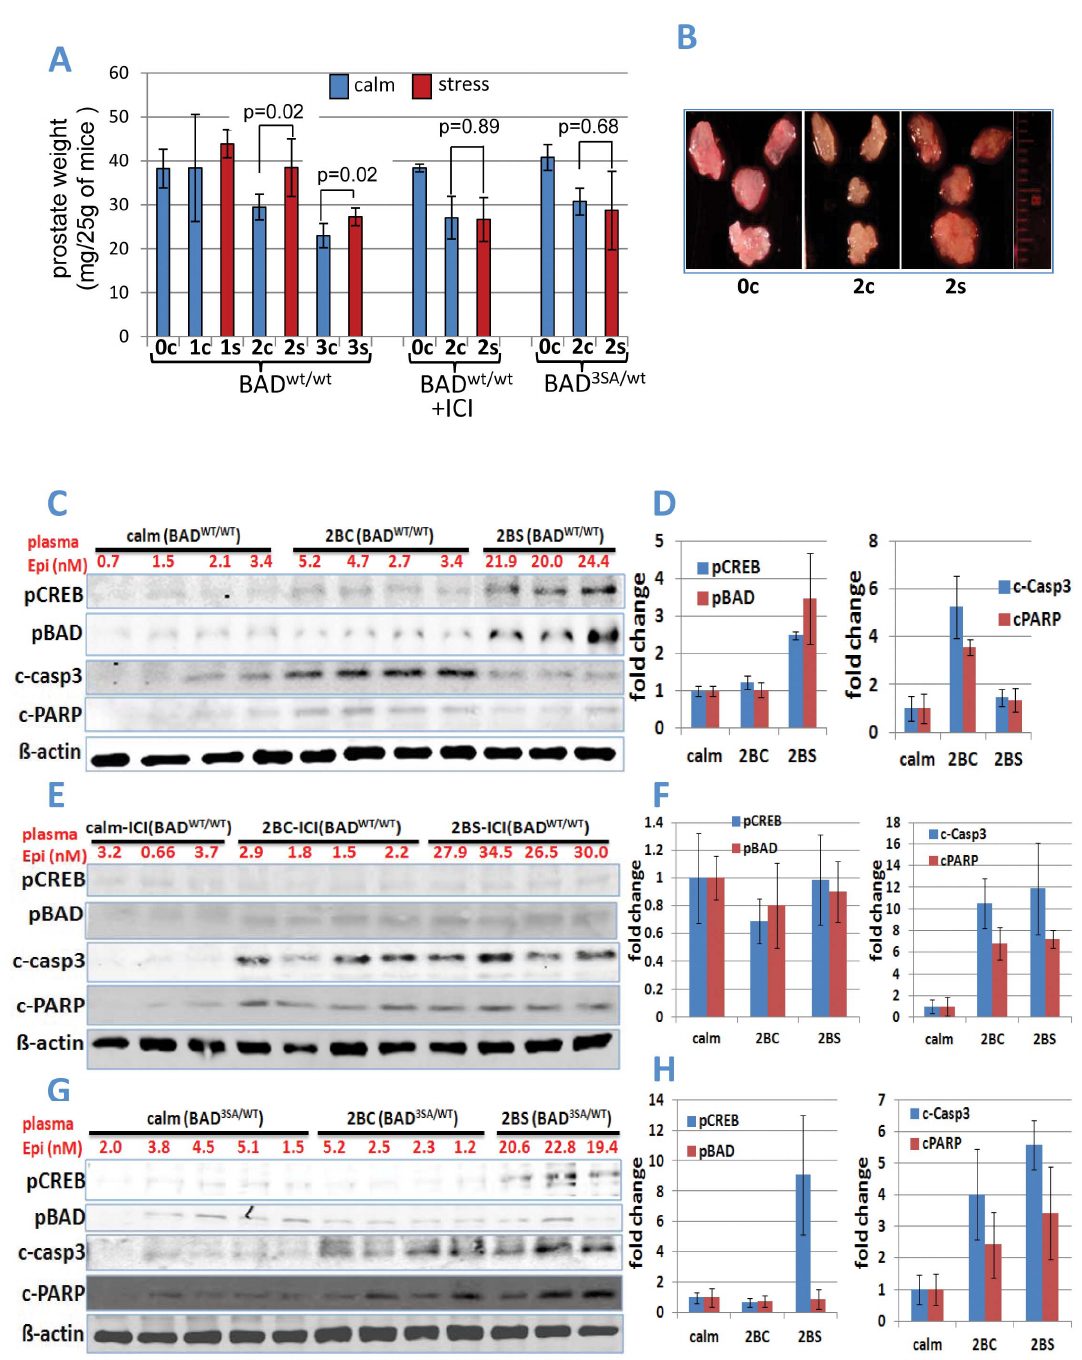
Figure 2. Behavioral stress delays androgen ablation-induced prostate involution and apoptosis via b 2-AR and BAD phosphorylation. A) Stress attenuates bicalutamide-induced decrease in prostate weight of mice via ADRB2/BAD signaling. S=stressed; C=calm. Intact calm mice (0c), numbers under the columns indicate days of bicalutamide treatment; BAD wt/wt mice with wild type BAD; BAD wt/wt + ICI, mice treated with ICI118,551; BAD 3SA/WT , mice with knockin on phosphorylation-deficient BAD3SA mutant (n=3 to 5 in each group). B) Microphotographs of dissected prostate glands from intact wild-type ( 0c ), calm mice after 2 injections of bicalutamide ( 2c ), and stressed mice after 2 injections of bicalutamide ( 2s ). ( C–H ) Western blot and densitometric analysis of Western blots of proteins extracted from of anterior prostate glands of wild-type mice (BAD WT/WT ) (C, D); wild-type mice treated with ICI118,551 (ICI, BAD WT/WT ) (E, F); and transgenic mice that express phosphorylation-deficient mutant BAD (BAD 3SA/WT ) (G, H). ( C, E, G ) Western blots conducted with antibodies to pSer133CREB (pCREB), pSer112BAD (pBAD), cleaved caspase 3 (c-casp3), cleaved PARP (cPARP) and b -actin. 3–4 representative samples for each treatment group are shown. Numbers over the Western blots show plasma epinephrine levels. Calm(BAD WT/WT ), mice with wild type BAD that were not stressed; 2BC(BAD WT/WT ), mice with wild type BAD that were given bicalutamide for 2 days and not stressed; 2BS(BAD WT/WT ), mice with wild type BAD that were given bicalutamide for 2 days and stressed; calm- ICI(BAD WT/WT ), mice with wild type BAD that were given ICI118,551 for 2days and not stressed; 2BC-ICI(BAD WT/WT ), mice with wild type BAD that were given bicalutamide and ICI118,551 for 2 days and not stressed; 2BS-ICI(BAD WT/WT ), mice with wild type BAD that were given bicalutamide and ICI118,551 for 2 days and stressed; calm(BAD 3SA/WT ), mice with phosphorylation deficient mutated BAD that were not stressed; 2BC(BAD 3SA/WT ), mice